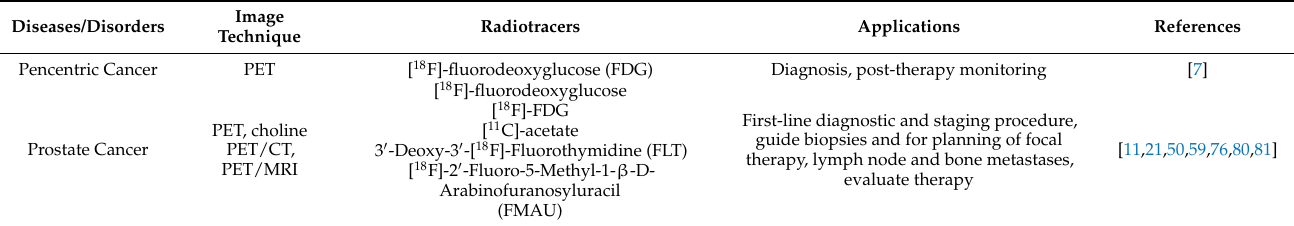
Table 3. PET radiotracers and their role in some diseases and